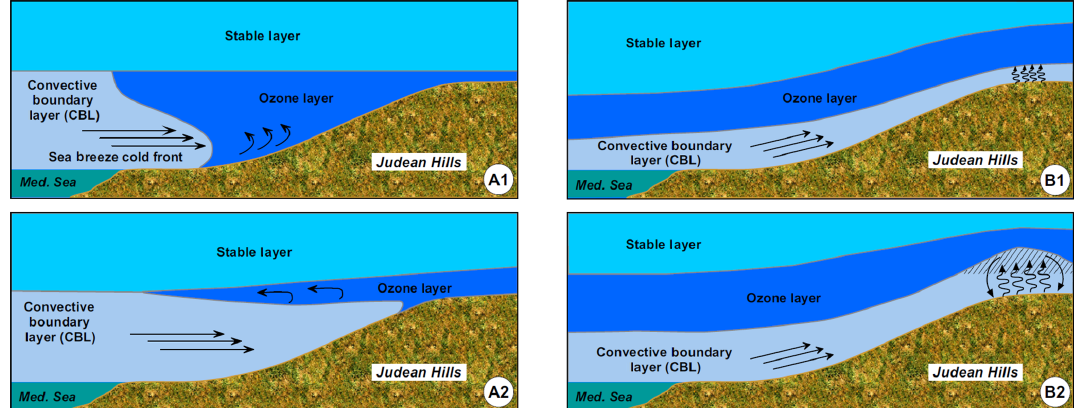
Figure 15. Scheme of the mechanism causing fumigation of a rich O 3 cloud toward the ground as it moves inland over the eastern Mediter- ranean coast during the weakening of a deep mode of the Persian Trough (from Dayan and Koch, 1996; ©American Meteorological Society; used with